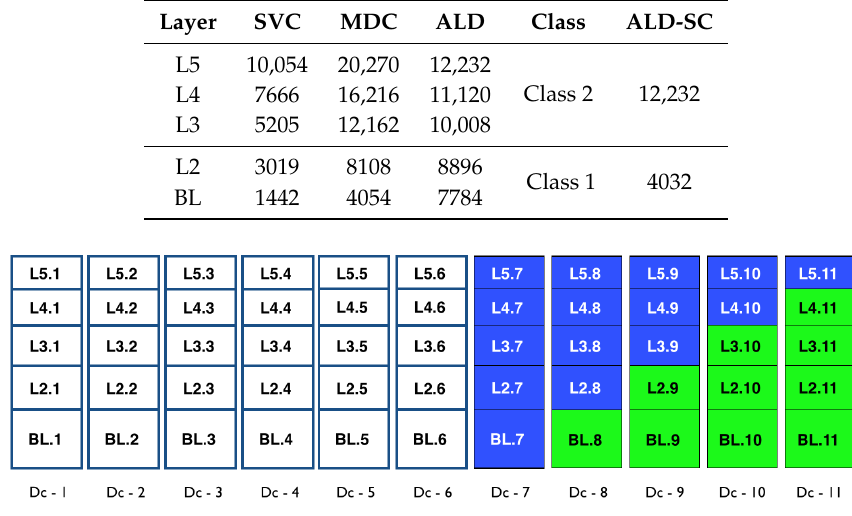
Figure 9. ALD with five-layer and an STF of 6.